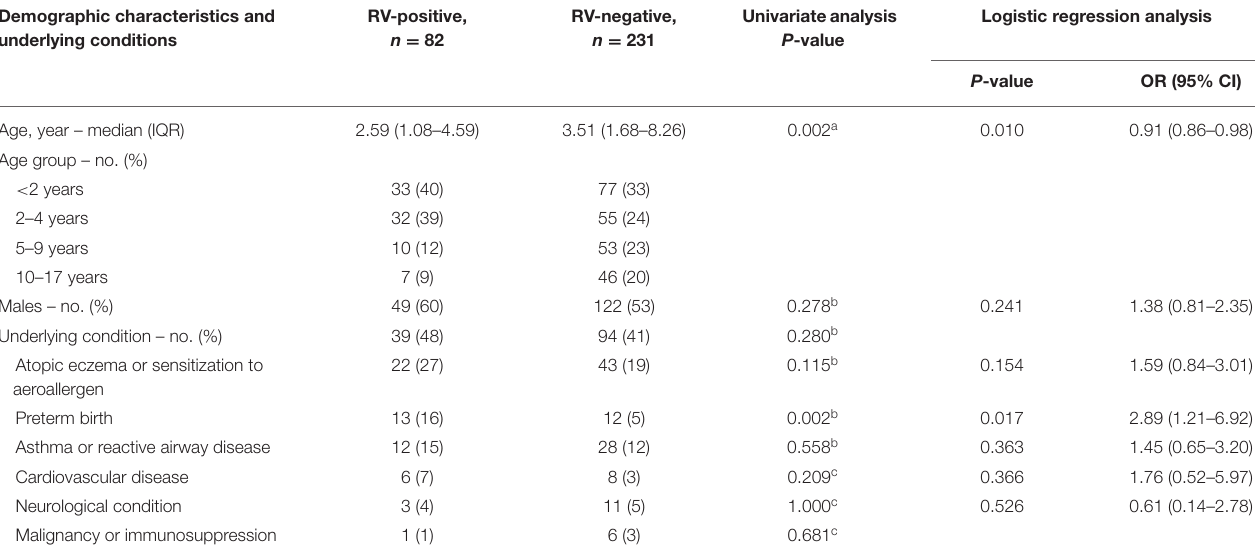
TABLE 1 | Demographic characteristics and underlying conditions of children with community-acquired pneumonia requiring hospitalization; RV-positive patients compared to RV-negative patients. Demographic characteristics and underlying conditions